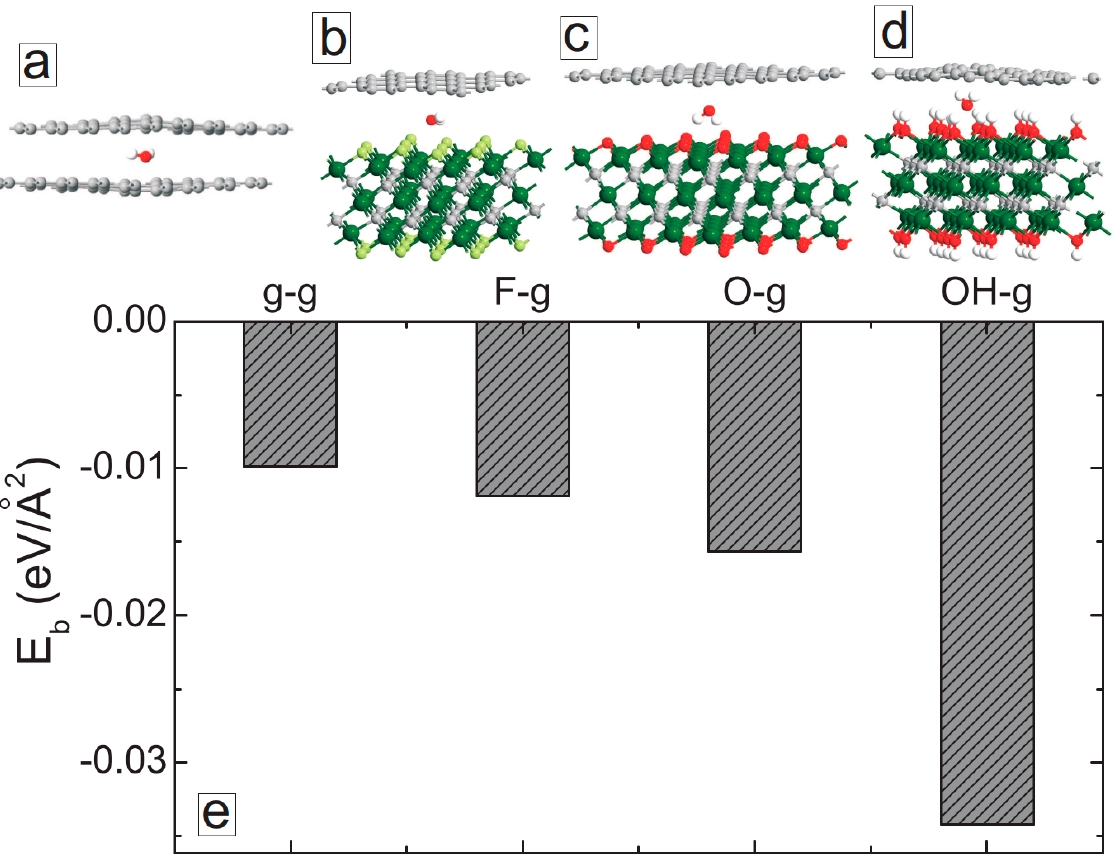
Figure 4. ( a – d ) Fully optimized structures of graphene/graphene and MXene/graphene systems in the presence of water molecules. ( e ) Binding energies of graphene/graphene and MXene/graphene systems in the presence of water molecules.